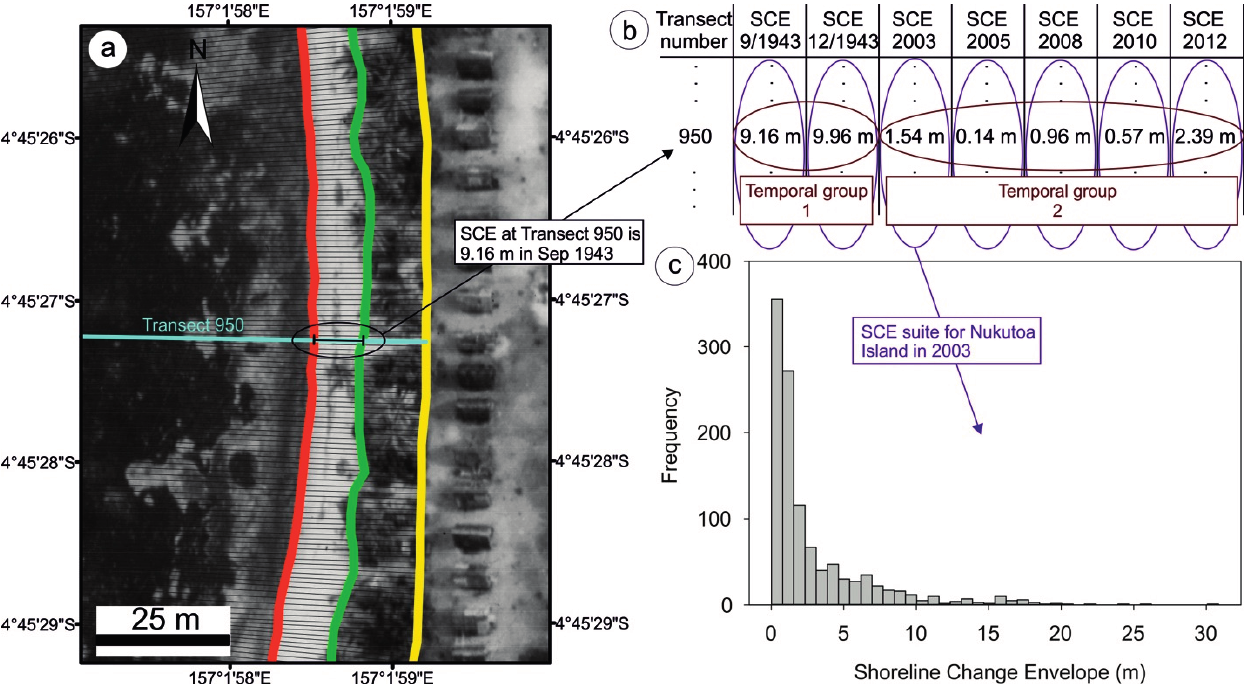
Figure 5. Derivation of the methodological approach. ( a ) Image section of Nukutoa Island in September 1943 exemplarily showing the baseline (yellow), edge of vegetation (green), toe of beach (red) and shoreline transects. The Shoreline Change Envelope is defined as the distance between the edge of vegetation and the toe of beach. ( b ) Table exemplarily showing the Shoreline Change Envelope at Transect 950 of Nukutoa Island for each year. Note the two temporal groups with considerably different Shoreline Change Envelope values at this transect. ( c ) Frequency distribution of the Shoreline Change Envelope suite for Nukutoa Island in 2003. The Shoreline Change Envelope suite is defined as the entirety of all Shoreline Change Envelope values for each